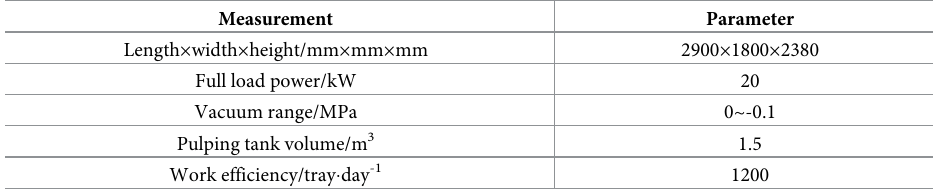
Table 1. Structure parameters of pneumatic molding